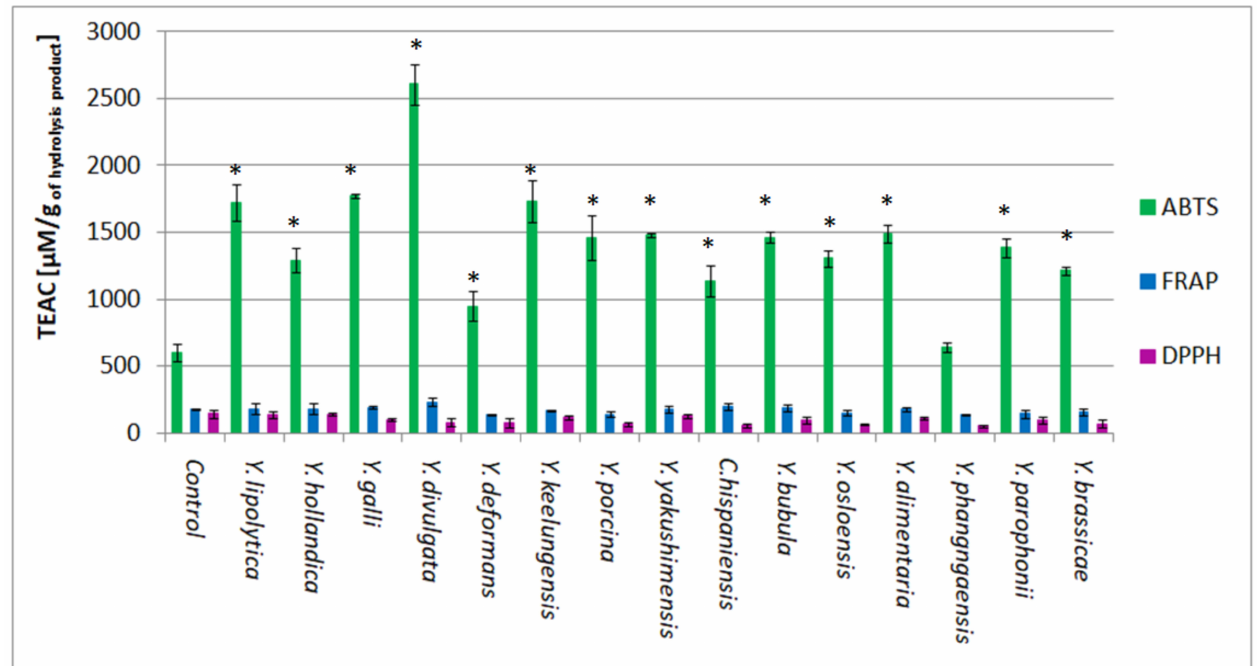
Figure 9. Comparison of antioxidant activity of BSG protein hydrolysates obtained in different yeast species cultures belonging to the Yarrowia clade. The results are presented as mean values ± SD. n = 3. The significance level was set at * p <